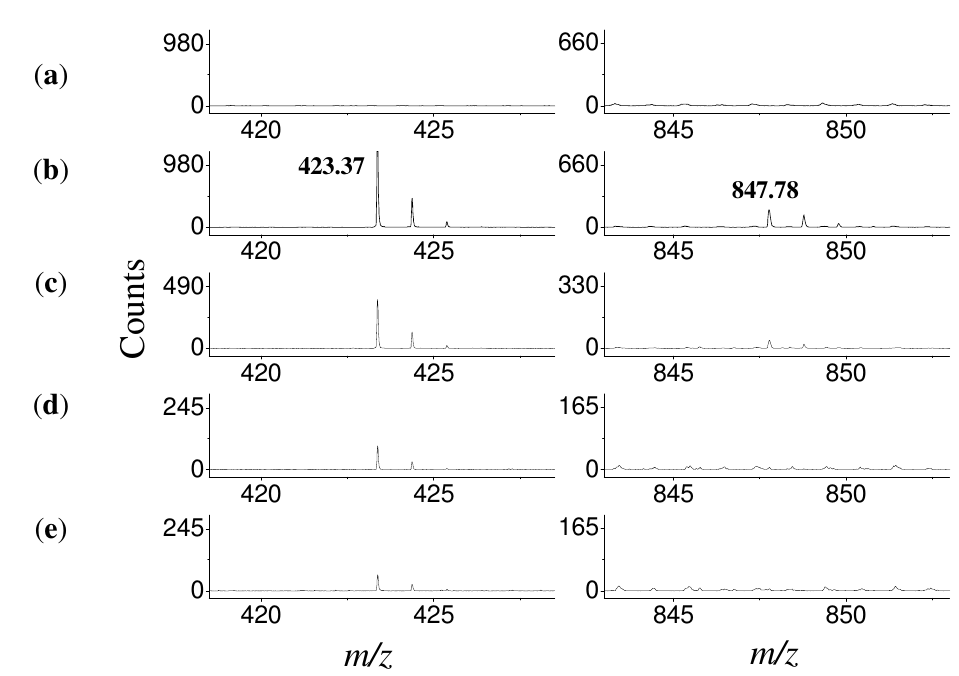
Figure 3. MALDI-TOF mass spectra of octacosanoic acid deposited onto Ti-6Al-4V following each step of SAM formation. The monomer region is shown in the left column and the dimer region in the right column. ( a ) All-trans retinoic acid matrix; ( b ) Solid octacosanoic acid; both the monomer (1168 counts) and the dimer (186 counts) can be detected via MALDI-TOF MS; ( c ) Octacosanoic acid film following aerosol spray deposition (monomer 391 counts; dimer 43 counts); ( d ) Octacosanoic acid SAM following solvent sonication (monomer 63 counts; dimer 0); Peaks detected in the dimer range of the mass spectra in ( a ), ( d ) and ( e ) are attributed to noise from the MALDI-TOF MS with peak heights < 2